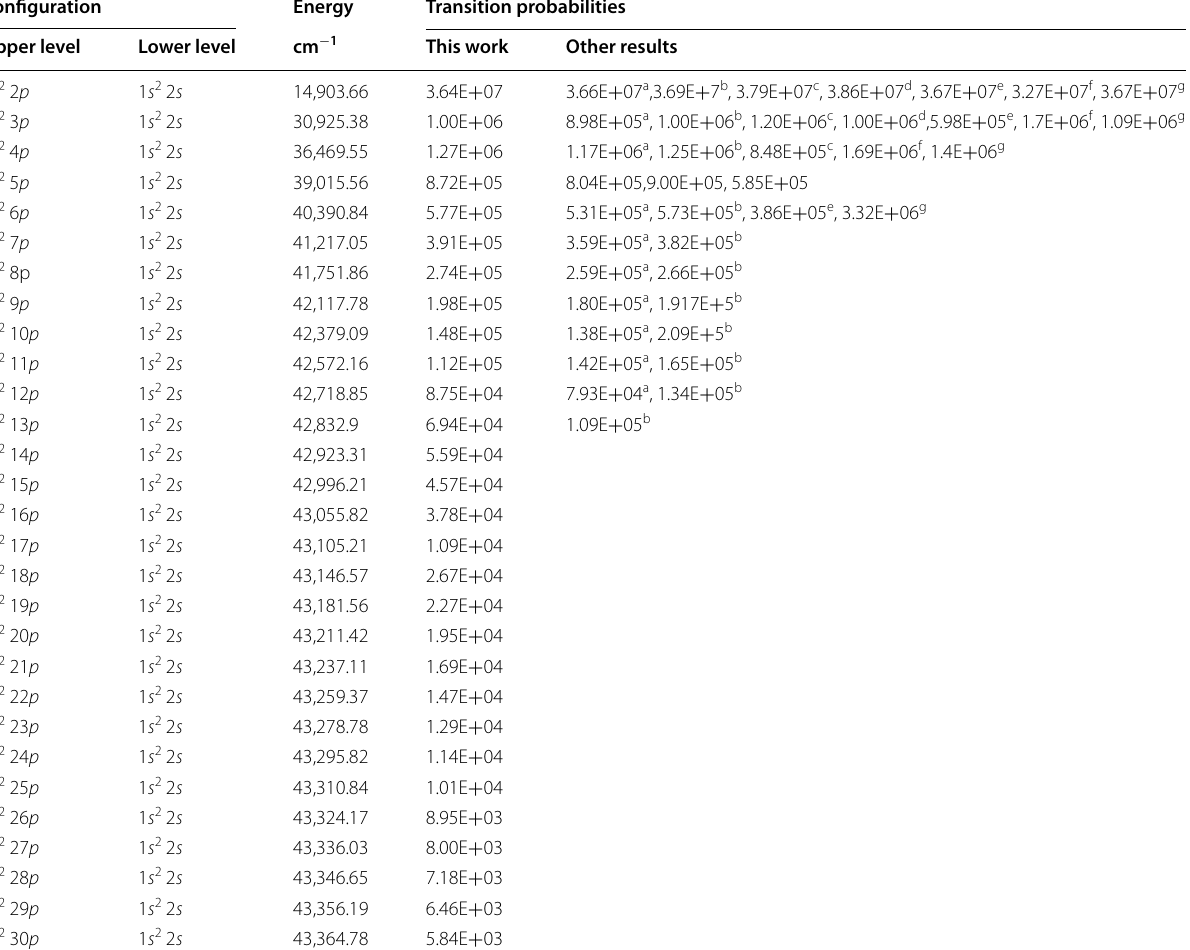
Table 1 Transition probabilities for the transitions 1 s 2 np –1 s 2 2 s calculated in this work compared with other